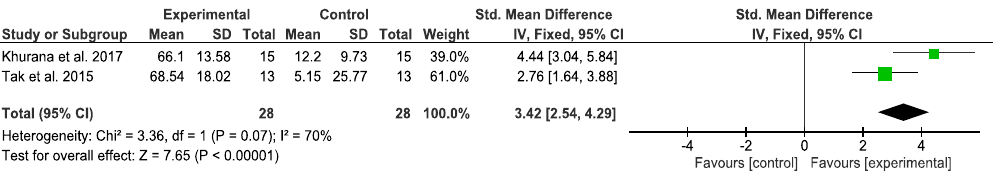
Range: 0–10. Item 1 is not used in the method score.